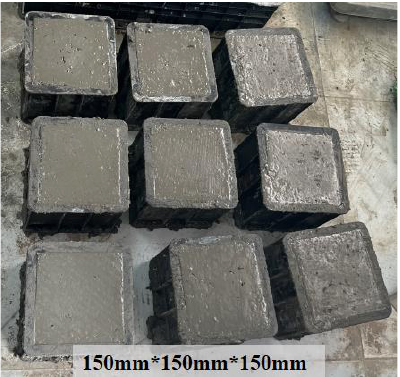
Figure 1. Concrete block.